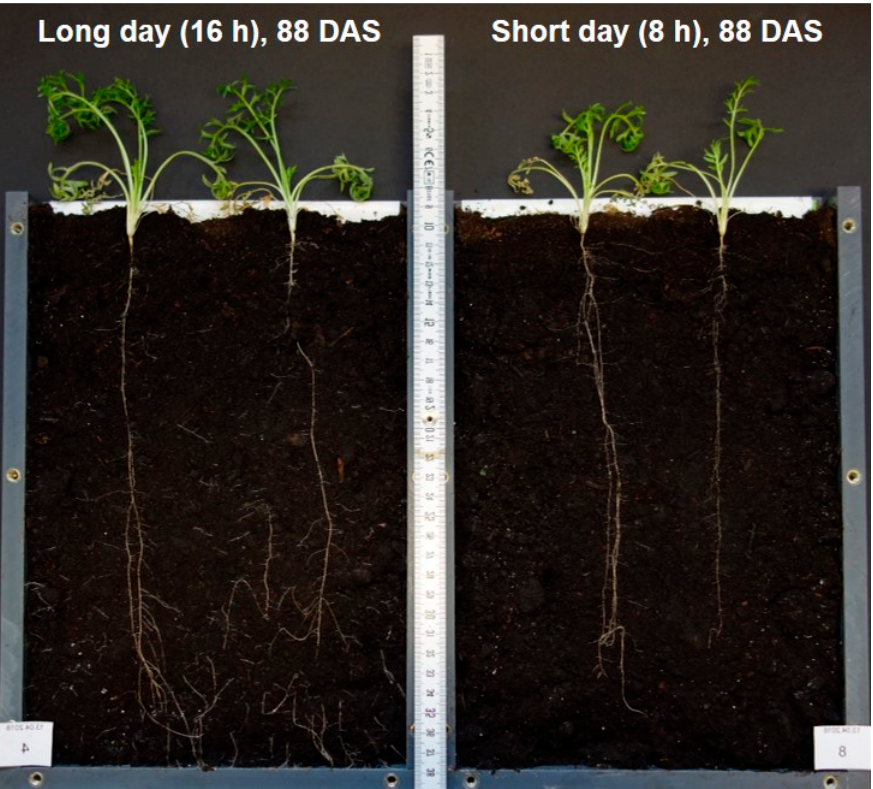
Figure 5. Habitus of yellow maca plants at harvest (88 DAS). The plants were grown in rhizoboxes under controlled conditions at long (16 h) or short (8 h) day length.